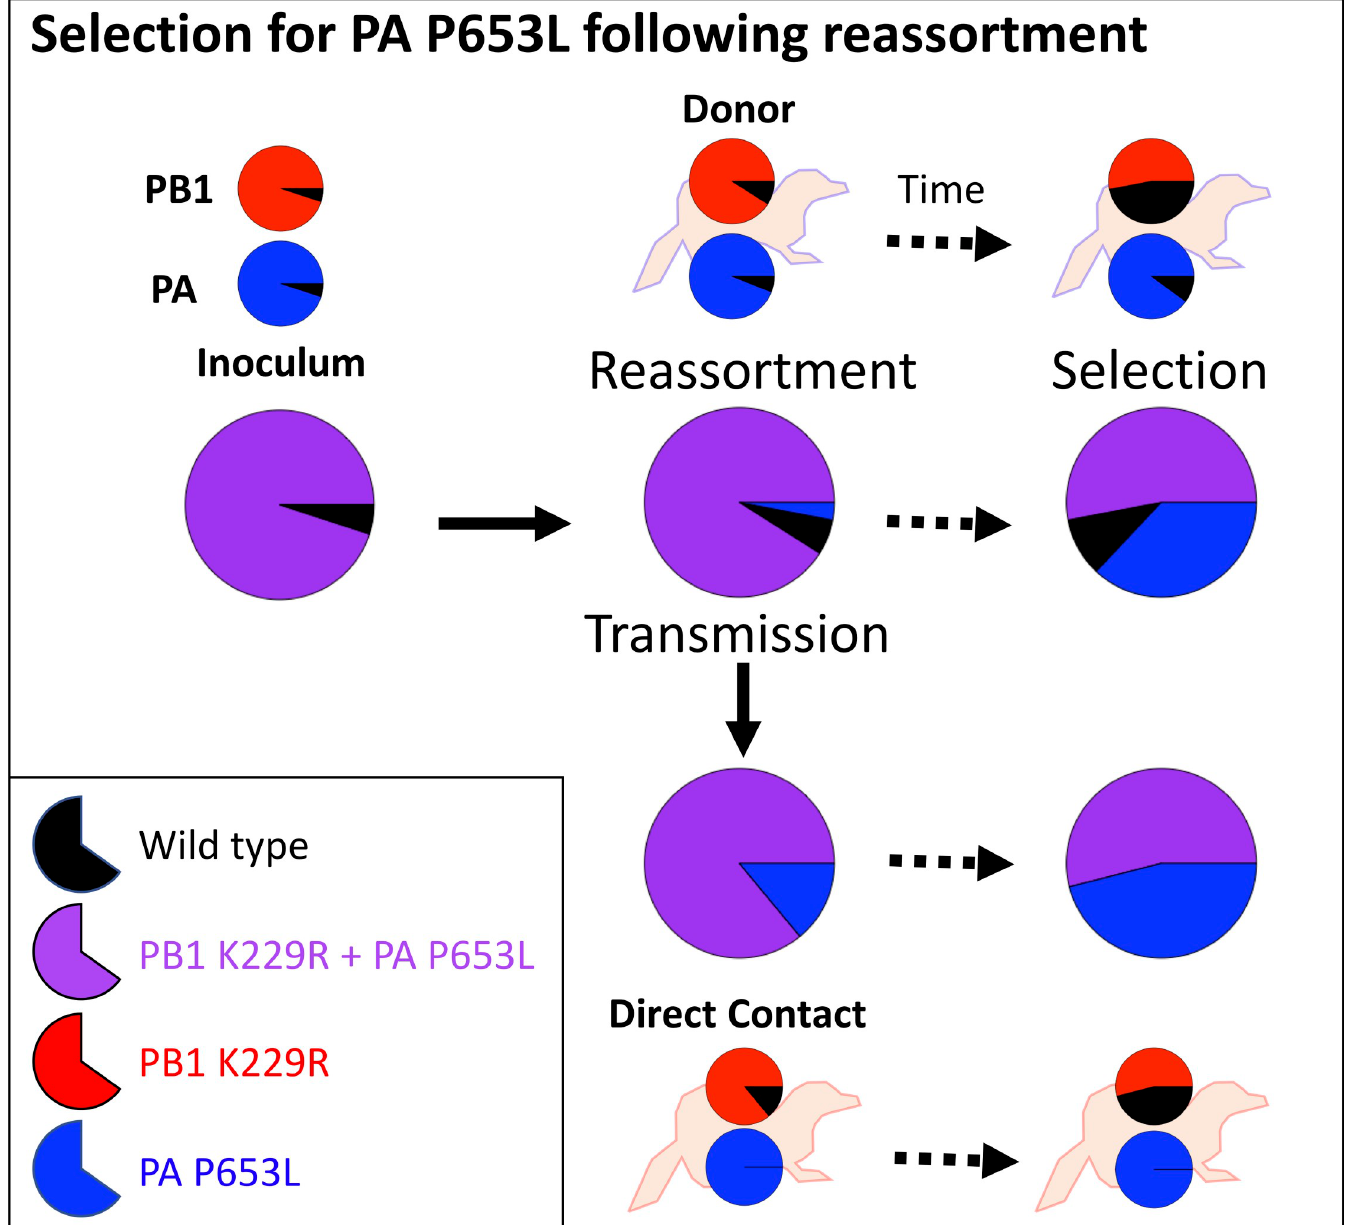
Fig 5. Schematic explaining how virus populations change for the donor and direct contact ferrets from Group 1. Large pie charts show the percentage of PB1 K229R + PA P653L mutant (purple) and wild-type viruses (black). Reassortment leads to the generation of the single mutant PA P653L (blue) in the donor which is transmitted to the direct contact. Smaller pie charts on each ferret show the sequencing results for PB1 and PA as in Fig 2.